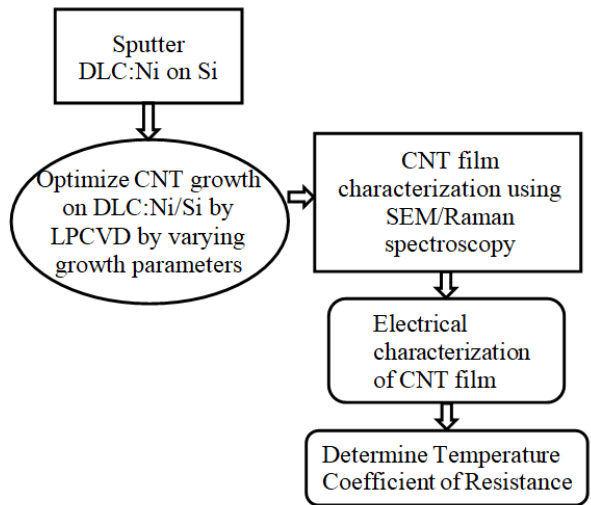
Figure 1. Methodology adopted for present work.